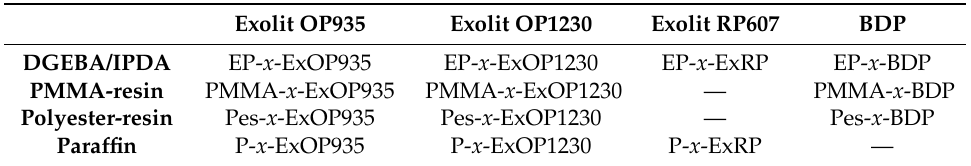
Table 1. Nomenclature of the produced flame retarded polymeric materials with x = concentration of the flame retardant, 5, 10, 15 or 20 wt % for Exolit OP935, OP1230 and RP607 and 10, 20, 25 and 35 wt % for BDP respectively.